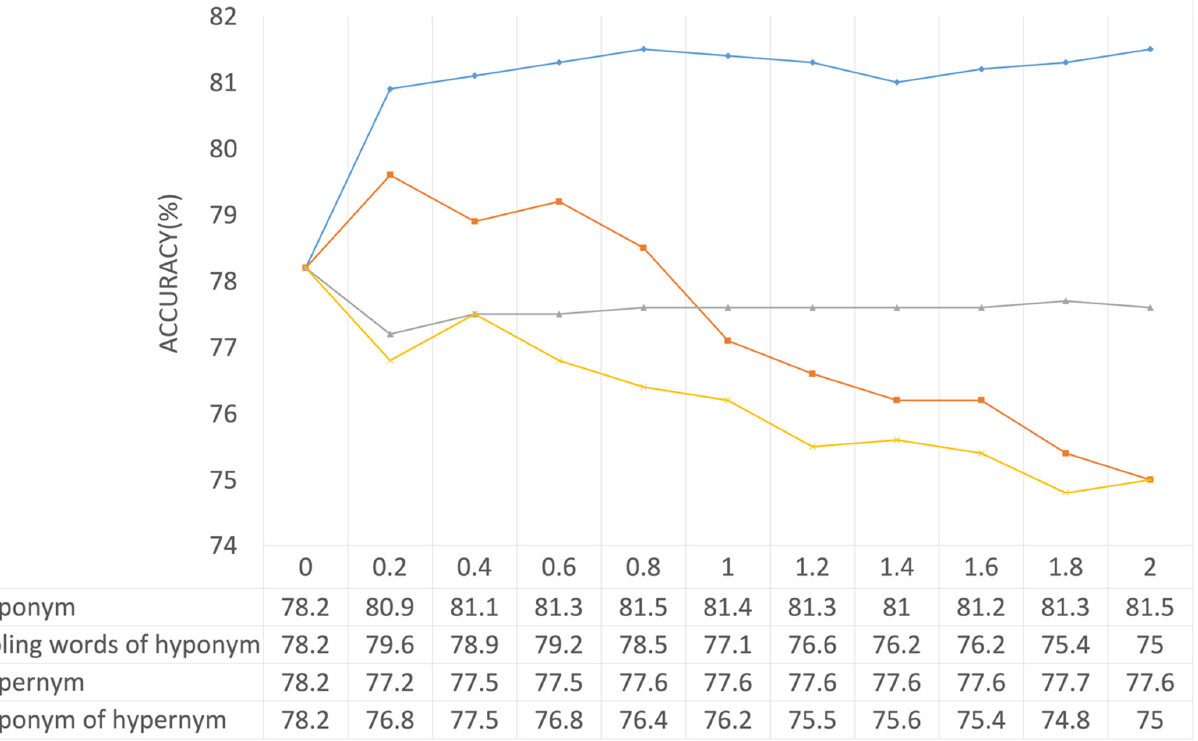
Figure 6. Change in accuracy according to the weight of relation word.